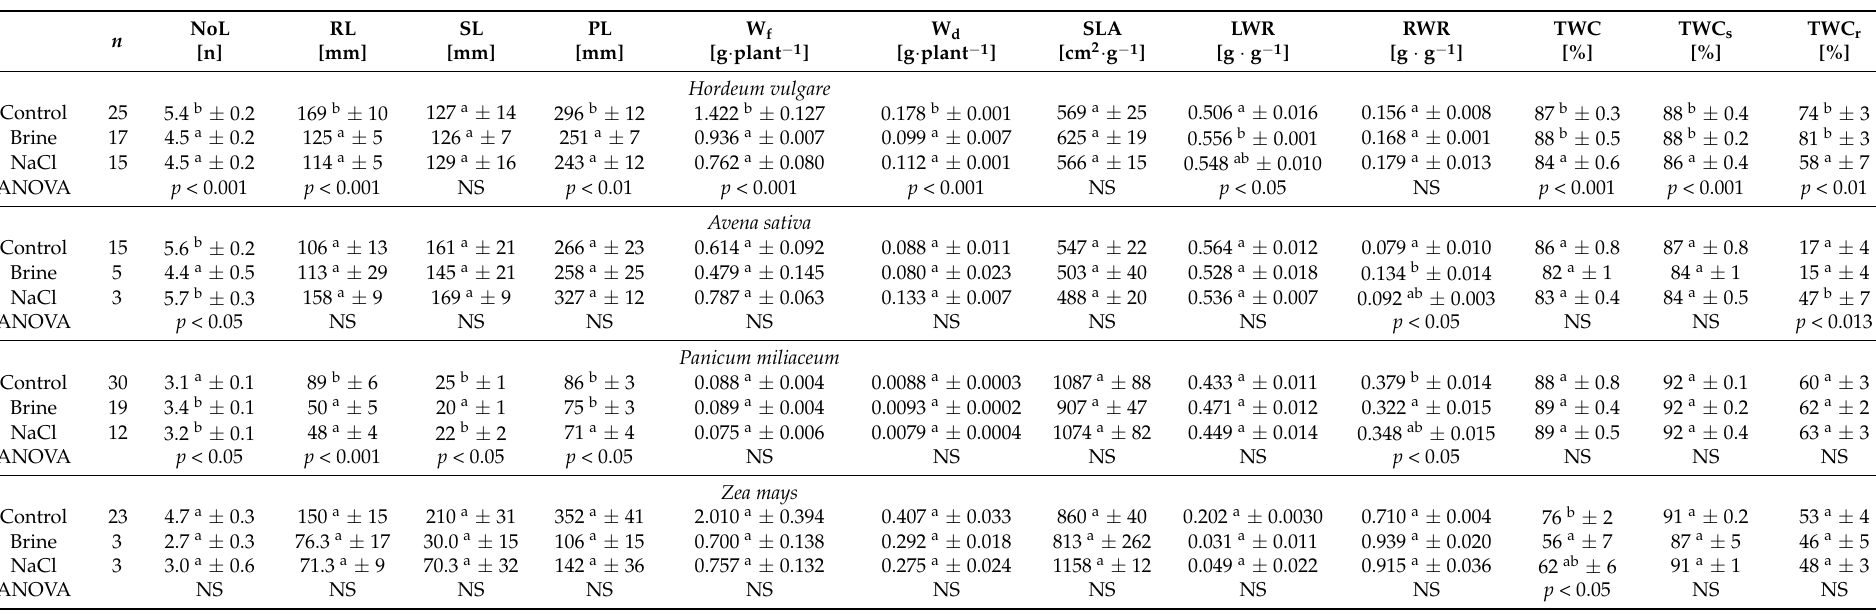
Table 2. Effect of NaCl and brine on selected growth parameters of model plants together with ANOVA results. Average values ( X ) with standard error (SE) are given ( X ±